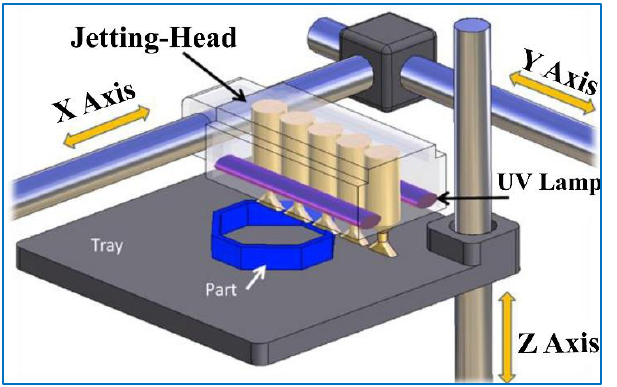
Figure 2. X, Y and Z axis in MJ